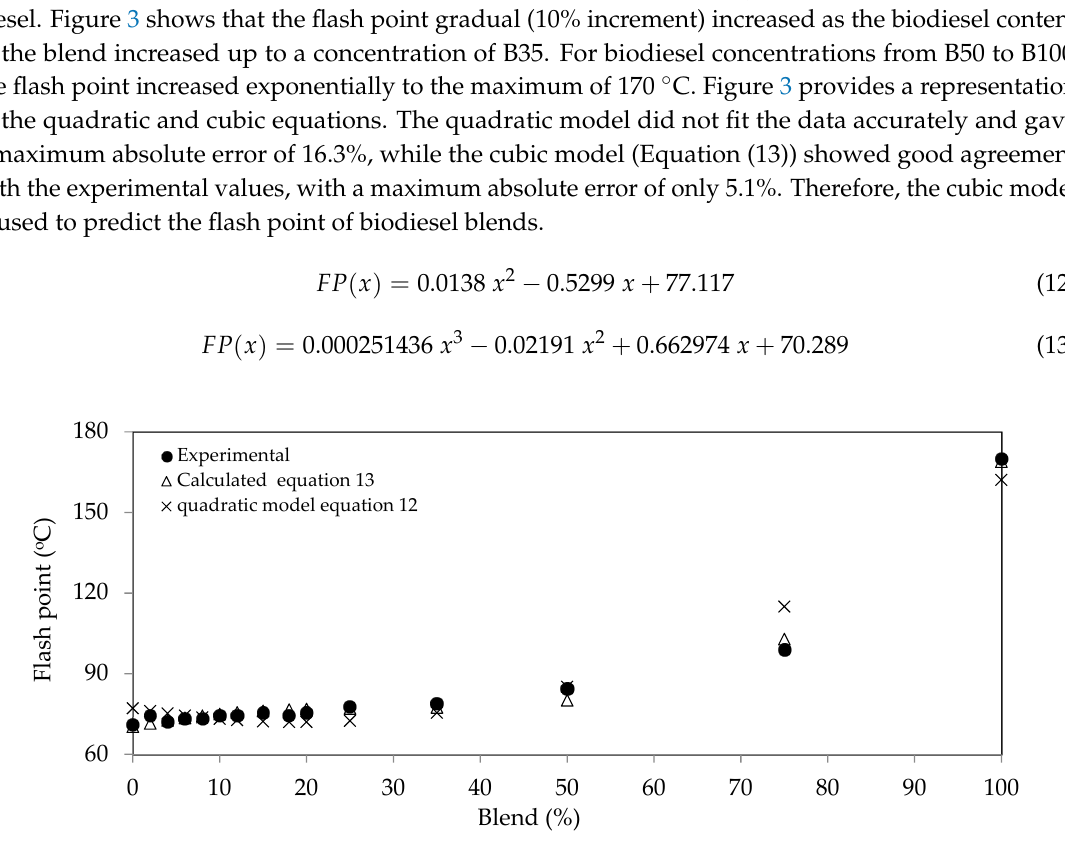
Figure 2. Viscosity variations with biodiesel content.